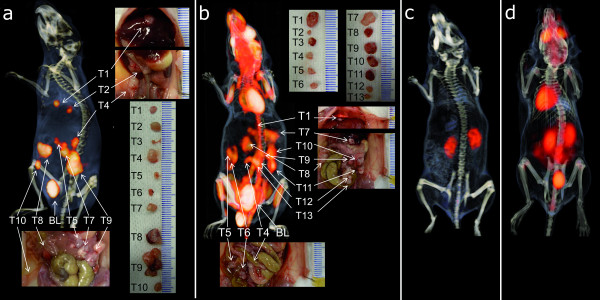
Images. 3D-volume rendering of the pretargeted immuno-PET scan (a) and the FDG-PET/CT scan (b) of the BALB/c nude mice with intraperitoneal LS174T tumors that received 6.0 nmol TF2 and 5 MBq 68Ga-IMP288 (0.25 nmol) with a 16-h interval (a) or 18F-FDG (b). The animals were imaged 1 h after 68Ga-IMP288 or 18F-FDG injection. Digital pictures were made during dissection to localize and measure individual tumors. On the pretargeted immuno-PET/CT images (a), all dissected tumors were very clearly distinguishable, except for the two very small tumors (1.2 and 4.7 μL, respectively). In the FDG-PET/CT images (b), arrows are pointed at the localizations where tumors were found at dissection, but the signal was difficult to be discriminated from the intestines. Figure 3c, d shows the PET/CT images of mice without intraperitoneal images after TF2 and 68Ga-IMP288 injection (c) or 18F-FDG injection (d).